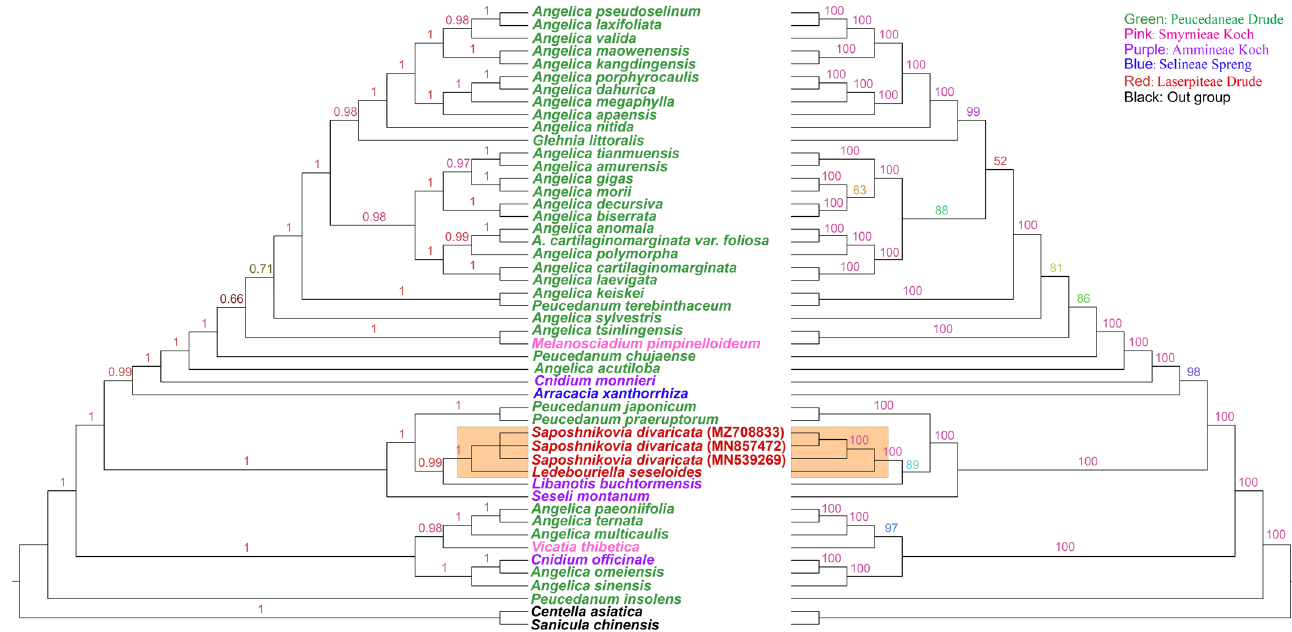
Figure 7. Phylogeny of 47 taxa within Apioideae Drude species based on the ML analysis of the cp genome’s IRs, LSC, and SSC regions with Sanicula chinensis and Centella asiatica as the outgroups based on FastTree (left) and IQ-TREE (right). The information of all chloroplast genomes used for phylogenetic analysis was shown in Table S3.